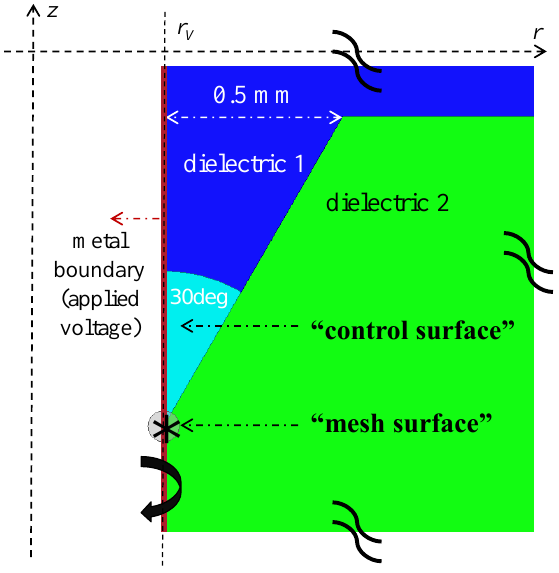
Figure 2: Part of the DUT containing the singularity to which the new approach is